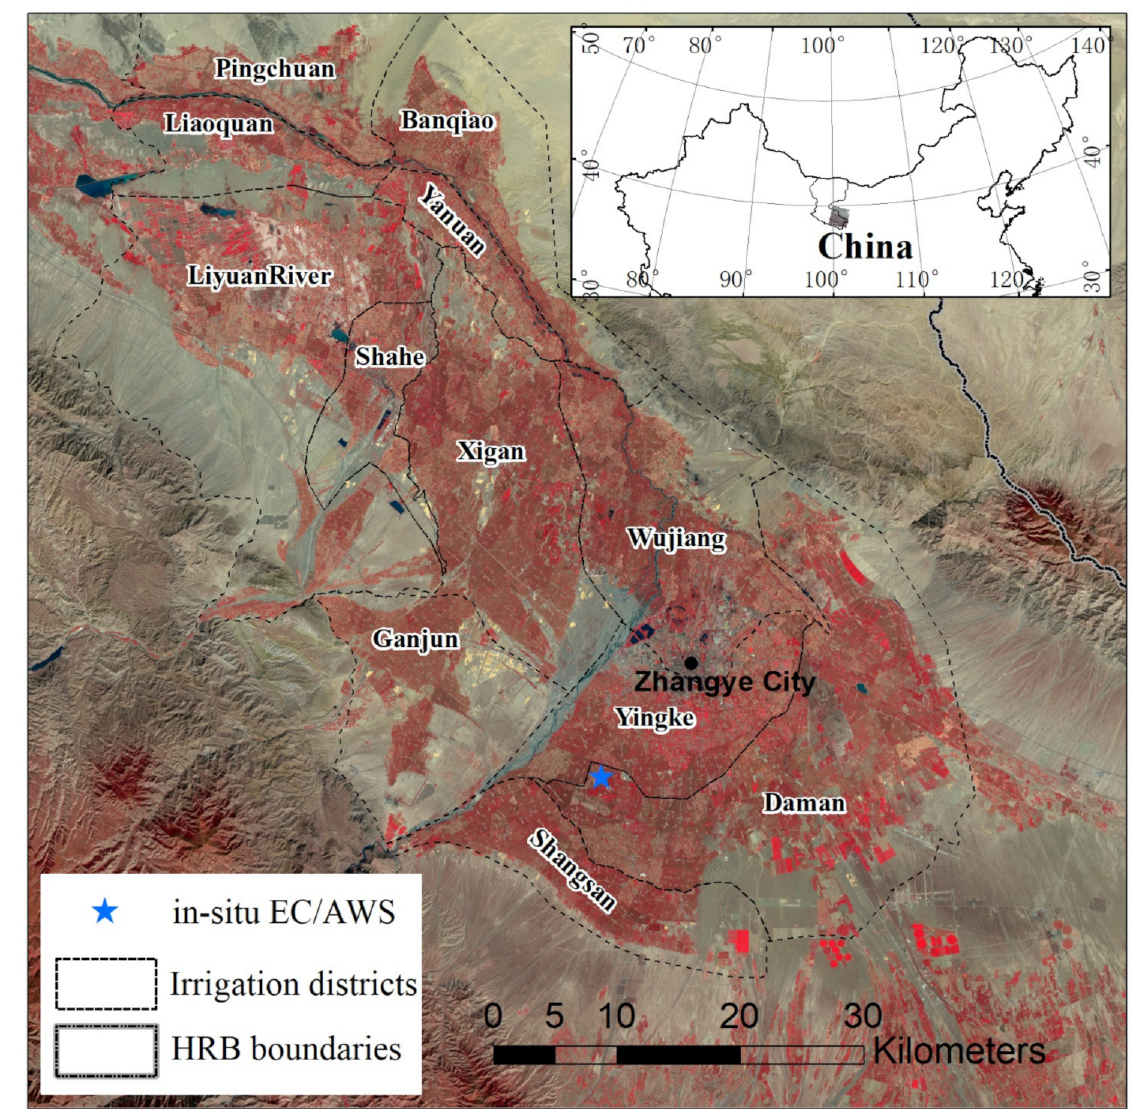
Figure 1. Spatial location of study area in Heihe River Basin (HRB) in Northwest China. Standard false-color map of composite 543 bands of Landsat 8 images on 29 September 2015 from the U.S. Geological Survey (USGS) dataset (https://earthexplorer.usgs.gov/ accessed on 6 April 2021) shows scope of study area, with irrigated area and cropland station (Daman superstation (DMS)) in midstream of HRB. In situ Daman superstation observation system includes eddy covariance (EC) and automatic weather station (AWS)